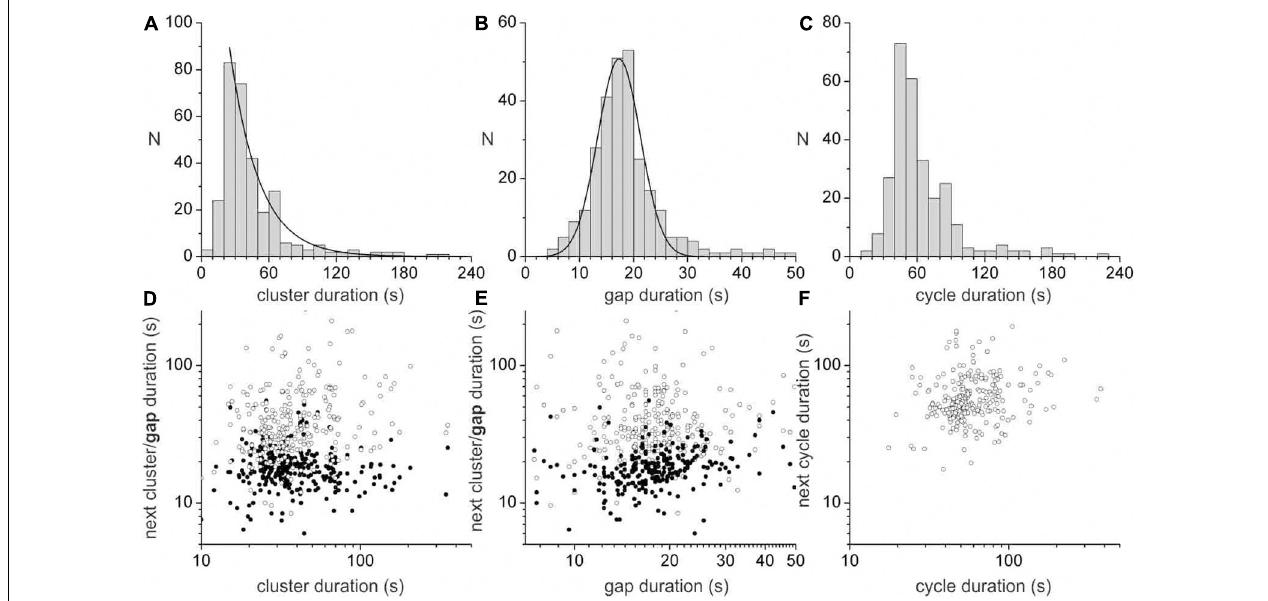
FIGURE 3 | Durations of clusters, gaps and cycles. The duration distribution of clusters (A) , gaps (B) and cycles (C) . A cycle is defined as a cluster and the following gap (cluster-gap cycle). Similar data was seen for cycles defined as a gap and the following cycle (gap-cluster cycle) (A) is fitted with an exponential (decay constant = 25.9 s) and (B) is fitted with a Gaussian (SD = 3.95 s (cid:48)(cid:48) , FWHM = 9.32 s). Correlation between cluster (D) or gap (E) duration and the duration of the next cluster (hollow points) or gap (filled points). (F) Correlation between cluster-gap cycle duration and the duration of the next cluster-gap cycle. Similar data was seen for gap-cluster cycles. Data were collated from ten